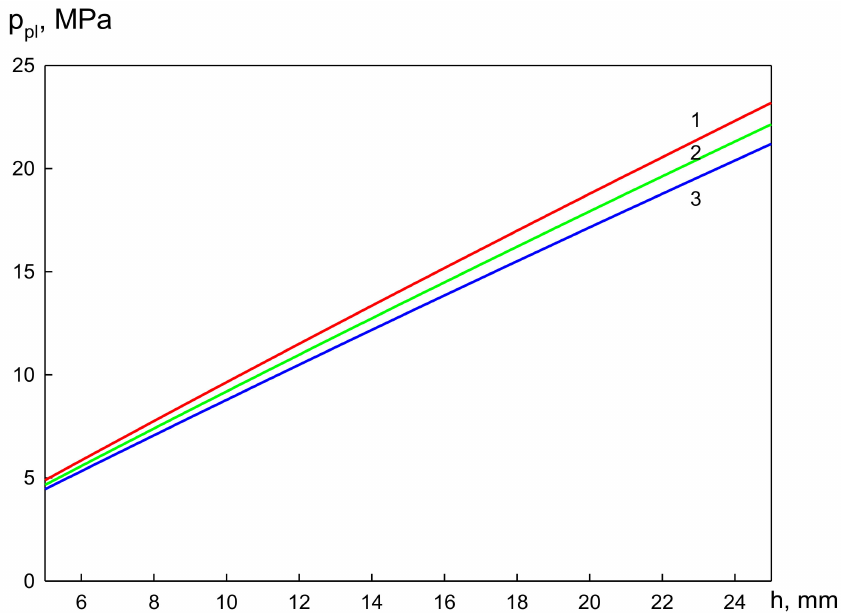
Figure 8. The dependence of the limit of plastic resistance on the wall thickness of the tube h = R ex − R in : T in = 293 K, T ex = 393 K, Λ p = 100 nm, δ = 10 nm, curve 1– R in = 0.1 m, curve 2–0.105 m and curve 3–0.11